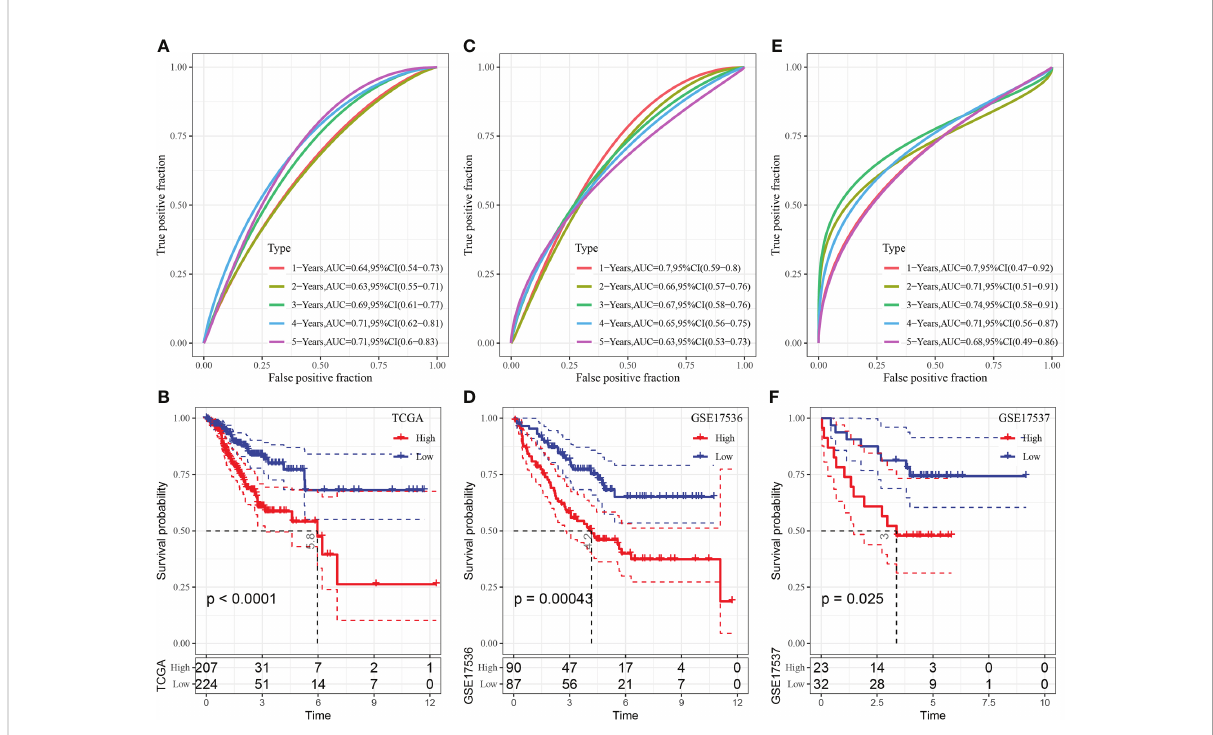
FIGURE 8 (A) ROC curve of the risk model constructed based on 4 genes in TCGA dataset; (B) KM curve of the risk model constructed based on 4 genes in TCGA dataset; (C) ROC curve of the risk model constructed based on 4 genes in the GSE17536 dataset; (D) KM curve of the risk model constructed based on 4 genes in the GSE17536 dataset; (E) ROC curve of the risk model constructed based on 4 genes in the GSE17537 dataset; (F) KM curve of the risk model constructed based on 4 genes in the GSE17537